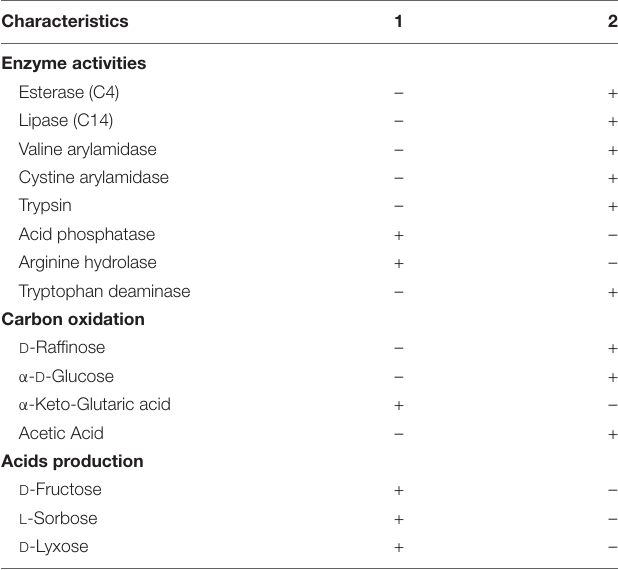
TABLE 2 | Phenotypic characteristics that distinguish Persicimonas caeni YN101 T from Bradymonas sediminis FA350 T